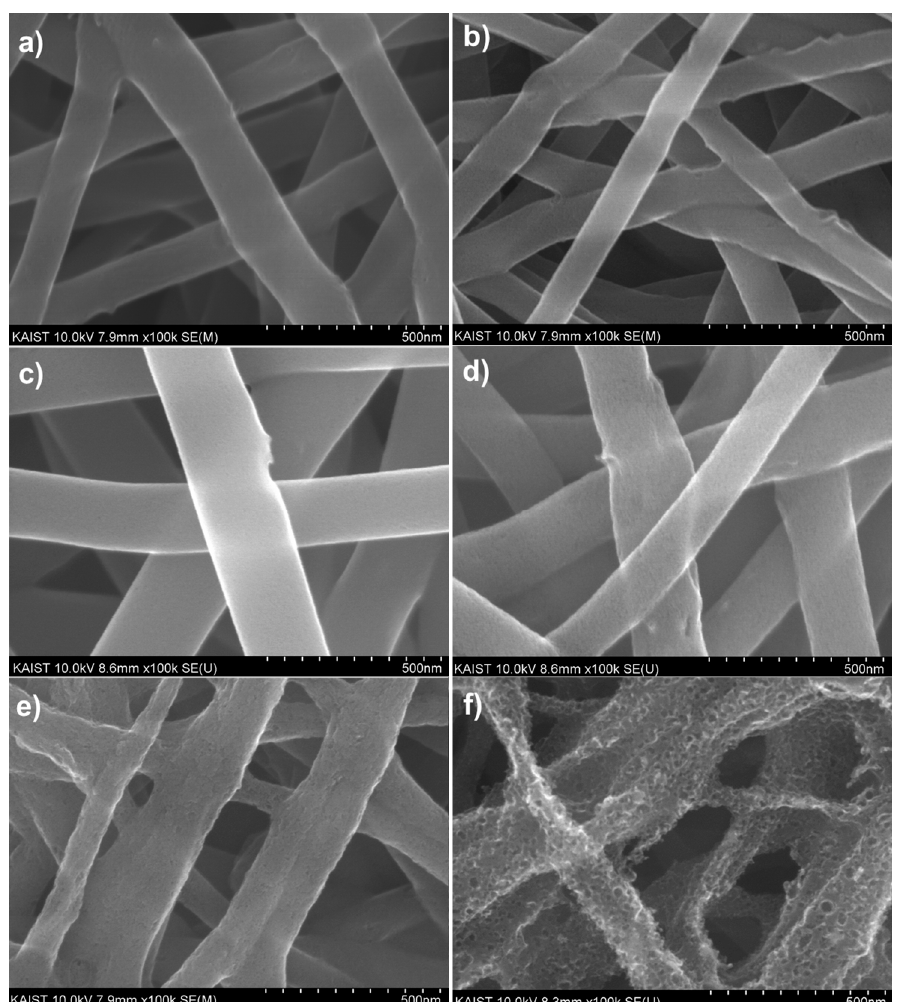
Figure 3. Scanning electron micrographs show ( a ) microporous carbon nanofibers carbonized at 700 °C; carbon nanofibers carbonized at 700 °C and activated at ( b ) 700 °C for 1 h; ( c ) 800 °C for 15 min; ( d ) 800 °C for 30 min; ( e ) 800 °C for 45 min; and ( f ) 800 °C for 1 h in CO 2 gas. Table 2. BET analysis of activated 1 wt % CNT-carbon nanofibers for various activation conditions.